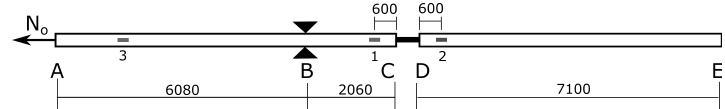
Figure 5. Dimensions of the split Hopkinson tension bar (SHTB) set-up. The strain gauges are in the positions 1, 2 and 3. Image adapted from [33]. For more information about this SHTB apparatus, consult the same